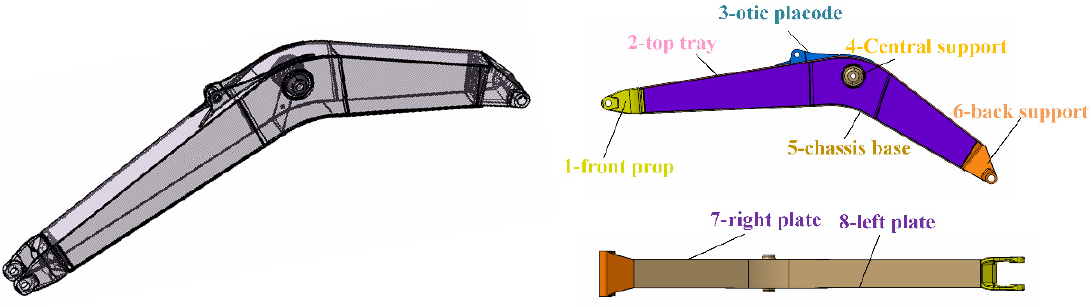
Figure 1. Excavator arm structure diagram.